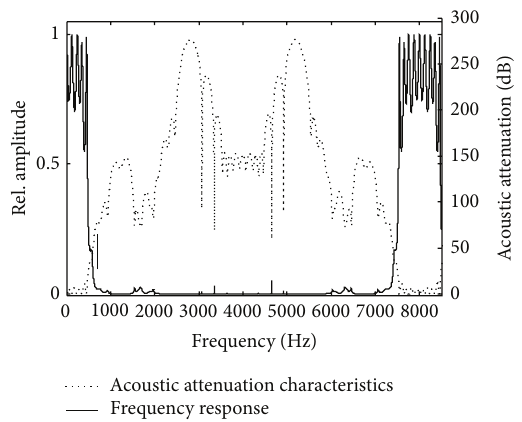
Figure 6: Simulation results of impulse frequency response and sound transmission loss for combined acoustic